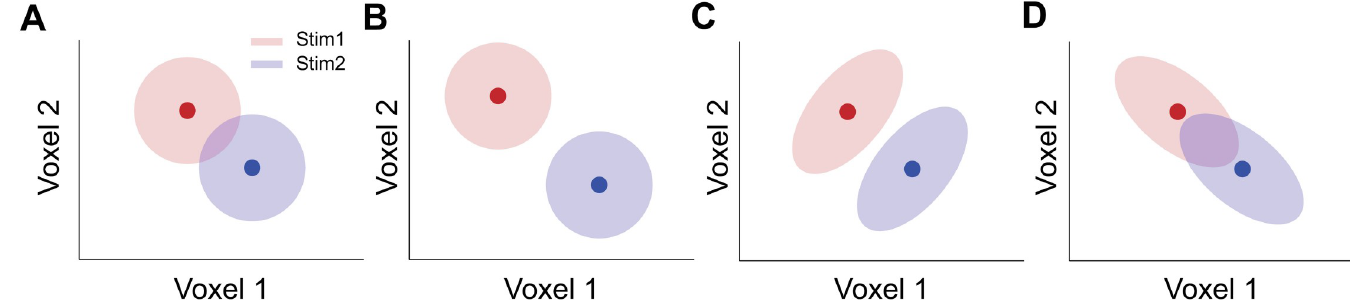
Fig 1. A two-voxel scenario in MVPA. The pool consists of two responsive voxels and the two color disks represent the trial-by-trial response distributions evoked by two different stimuli. Panel A illustrates the original state of the population responses. Decoding performance can be improved via either a bigger separation of the mean population response (panel B) or changes in the covariance structure (panel C). Representational structures in panels B and C indicate improved population codes but have distinct underlying mechanisms. Panel D illustrates that certain covariance changes can worsen